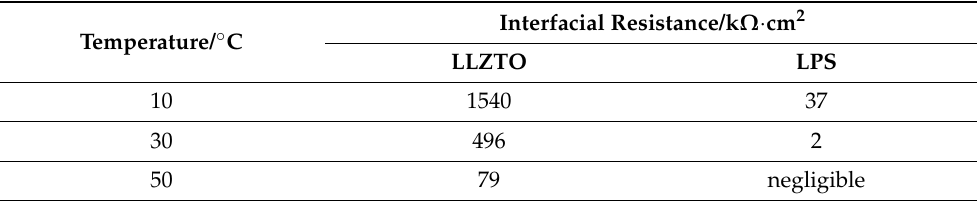
Table 1. Table showing the interfacial resistances between PEO 10 :LiTFSI and the ceramic